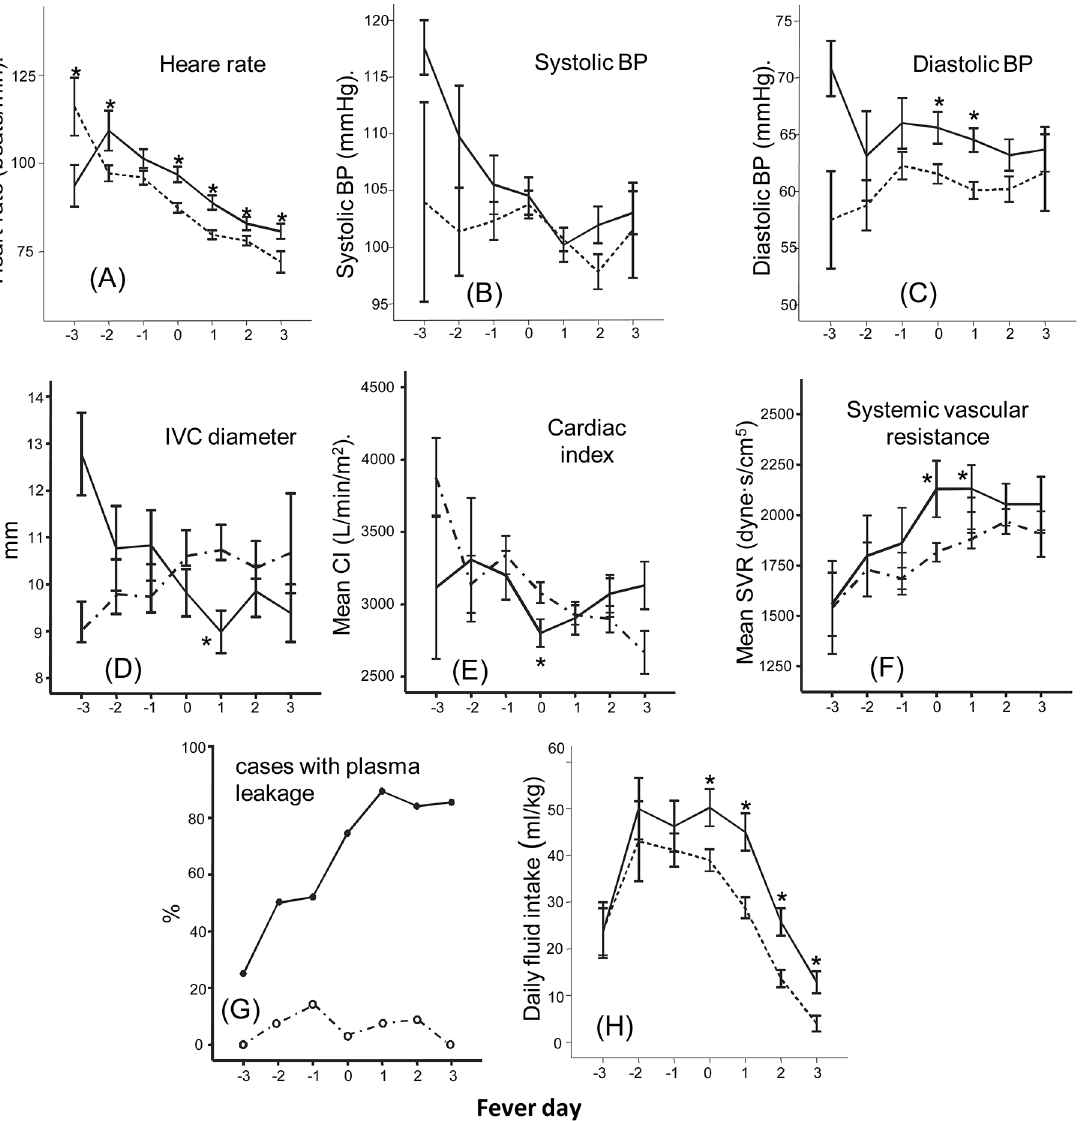
Fig 1. Hemodynamic status and plasma leakage in dengue by fever day. Heart rate (A), systolic blood pressure (B), diastolic blood pressure (C), inferior vena cava diameter (D), mean cardiac index (E), systemic vascular resistance (F), frequencies of cases with a pleural effusion or ascites (G), and daily fluid intake (H) of dengue fever (dotted line) and dengue hemorrhagic fever cases (solid line) over the course of the illness. Fever day 0 denotes day of defervescence. * different from dengue fever cases ( P < .05). The numbers of cases were: fever-day -3 (DF 4, DHF 5), fever-day-2 (DF 13, DHF 9), fever- day-1(DF 43, DHF 26), fever-day-0(DF 104, DHF 56), fever-day+1(DF 119, DHF 62), fever-day+2(DF 70, DHF 60), fever-day+3(DF 13, DHF